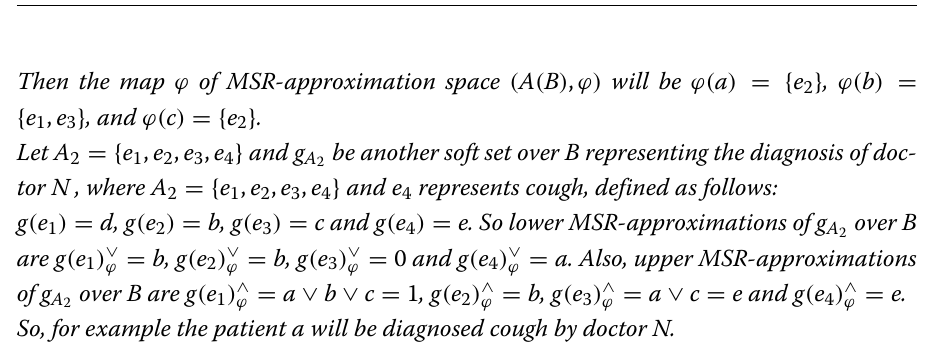
Table 1 Lattice information system of the soft set f A e 1 e 2 e 3 a 0 1 0 b 1 0 1 c 0 1